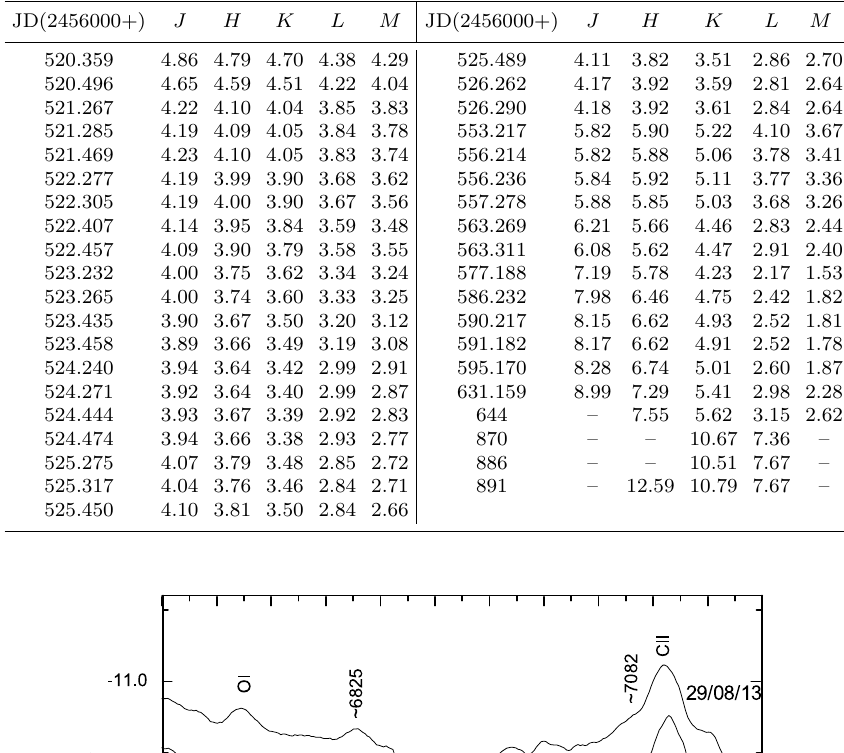
Table 2. JHKLM photometry of Nova Delphini 2013.